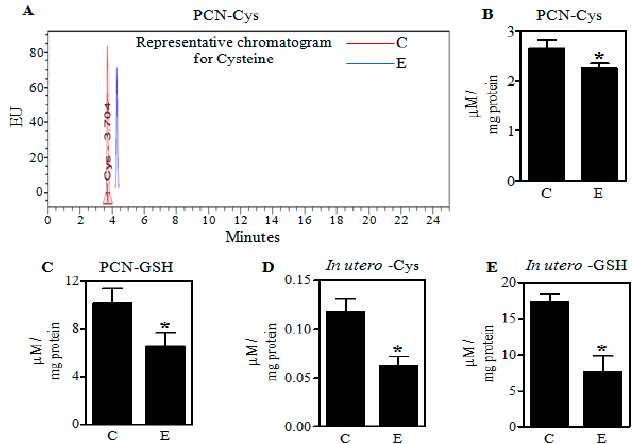
Figure 3. Effect of ethanol on Cys and GSH levels in PCNs and fetal brain cortices. A representative